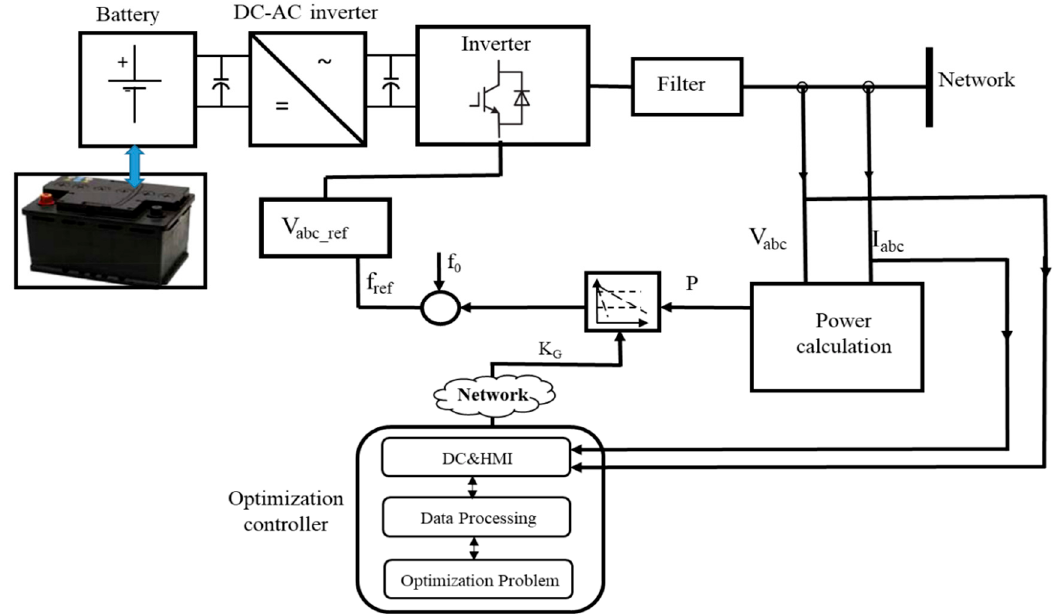
Figure 2. Block diagram of the online operating system.